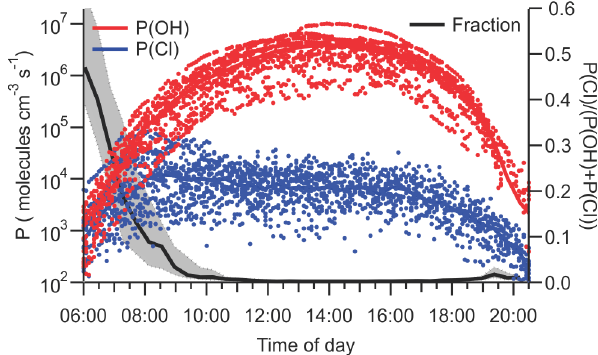
Figure 10. Plots of instantaneous rates of Cl (blue) and OH (red) radical production from ClNO 2 photolysis and reaction of O 1 D, generated from O 3 photolysis, with H 2 O and as a function of time of day. The fraction of radicals produced from ClNO 2 photolysis is shown in black. The solid line indicates median values, and shaded areas the 75th and 25th